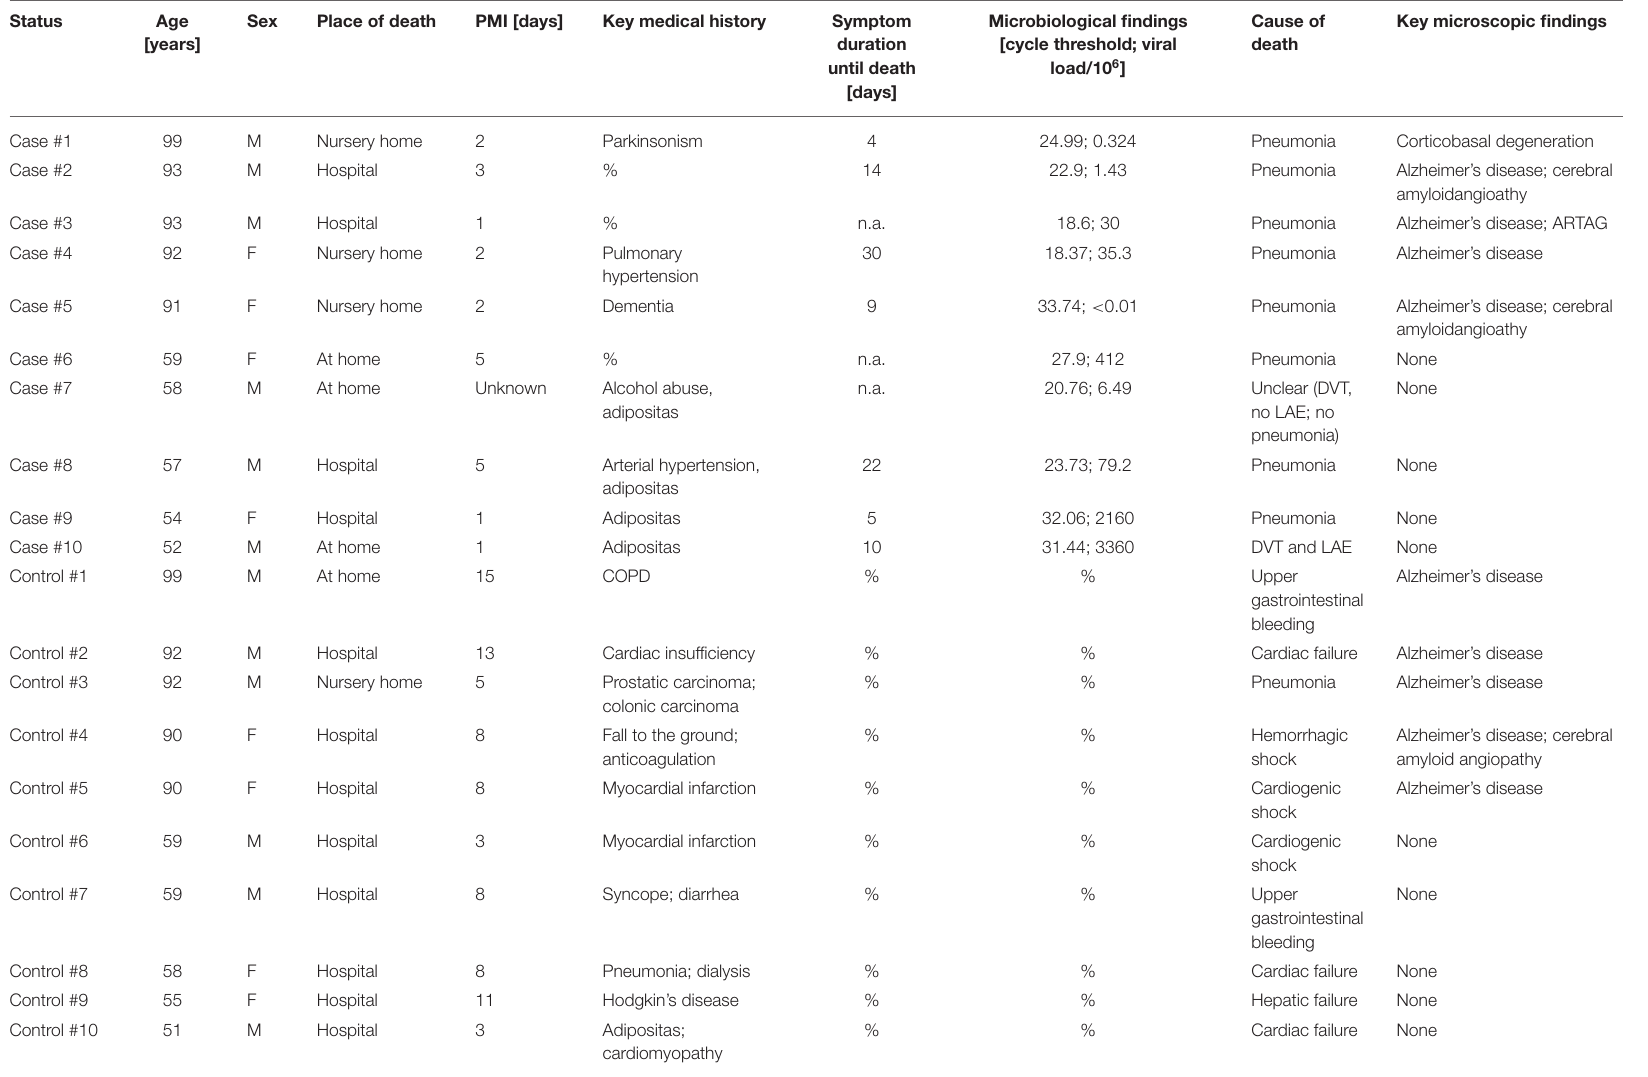
TABLE 2 | Clinical details of cases and